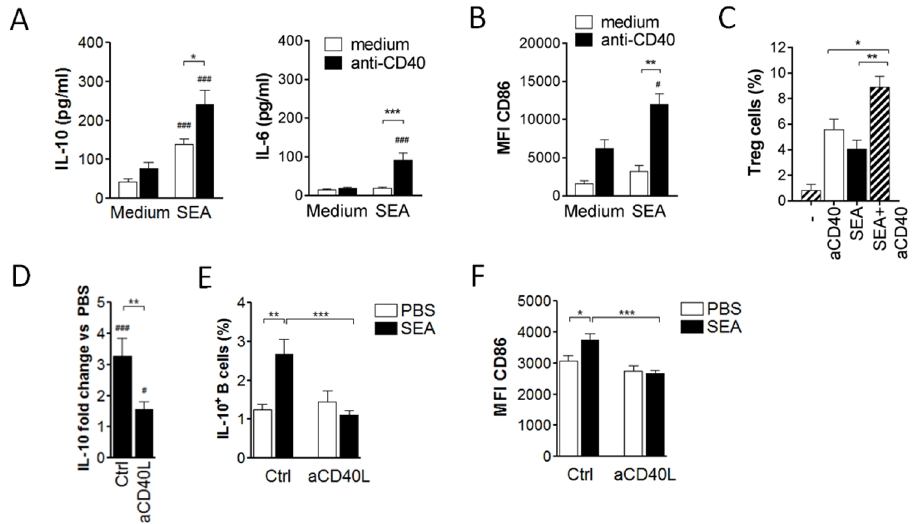
Fig 6. CD40 ligation enhances SEA-induced Breg cell development. (A, B) Splenic B cells from na ï ve mice were culturedwith 20 μ g/ml SEA or medium as control, with or without additionof anti-CD40co- stimulatoryantibody. After 3 days of culture, supernatants were analyzedfor IL-10 and IL-6 by ELISA (A) and B cell CD86expressionby flow cytometry (B) . Summary of 6 experiments. (C) Splenic B cells were stimulated for 3 days with anti-CD40mAb (2 μ g/ml) and SEA (20 μ g/ml) or anti-CD40alone, and subsequently co- culturedwith CD4 + CD25 - sorted splenic T cells. After 4 days, the frequency of CD25 + Foxp3 + Treg cells within the CD4 T cell populationwas determined by flow cytometry. Summary of 4 experiments. (D-F) Mice were i.p. injectedwith two doses of 100 μ g SEA or PBS as control. CD40 ligandwas blocked in vivo by i.p. injectionof 200 μ g hamster anti-mouse CD40ligandor 200 μ g hamster IgG as control (Ctrl) for 4 times, every 4 days starting at day -1 before SEA/PBS treatment. At day 14 after the first SEA/PBS injection, splenicB cells were in vitro restimulated with SEA for 2 days. Summary of 2 experiments (N = 8). (D) Fold increase of IL-10 in supernatants from B cells of SEA-injected versus PBS-injected mice. (E) Intracellular IL-10 expression of B cells after additionof BrefeldinA to the last 4 hours of the culture. (F) Mean fluorescence intensity of CD86 on B cells. Significantdifferences are indicatedwith * p < 0.05, ** p < 0.01, *** p < 0.001 as tested by Mann- Whitney test. # p < 0.05, ## p < 0.01 and ### p < 0.001 indicatessignificantdifference by one-sample t-test of log-transformed data (D) or to respective medium control by Mann-Whitney